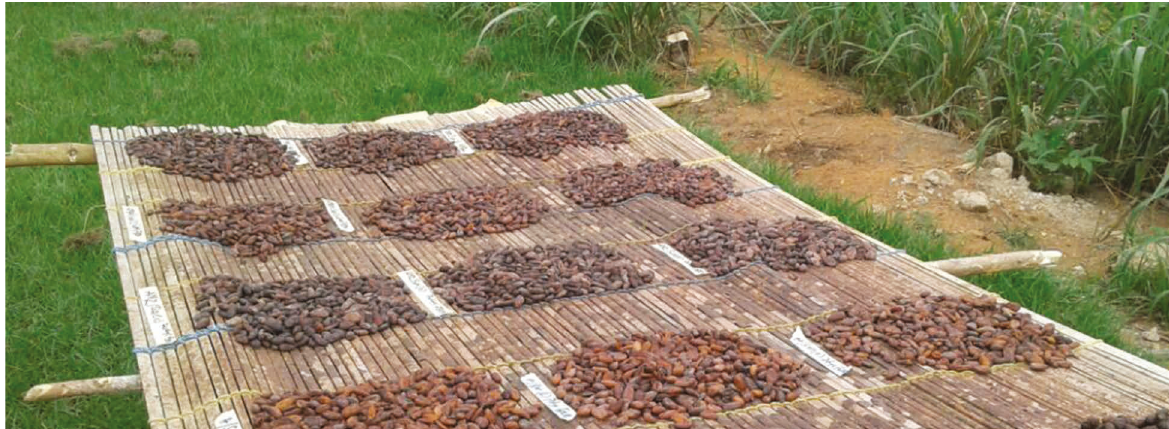
Figure 1: Cocoa beans undergoing sun drying in the